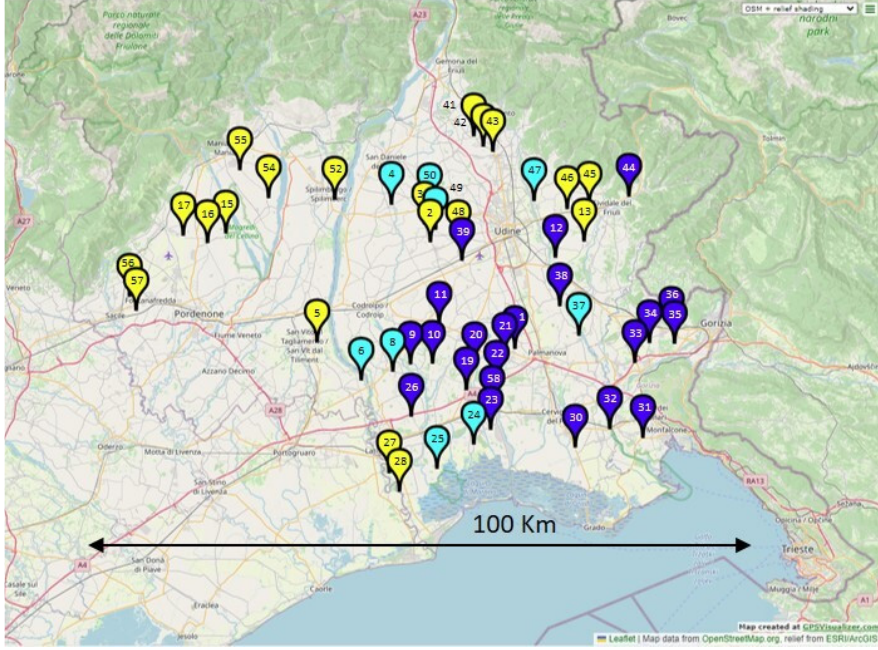
Figure 3. Geographical distribution of the accessions having only the leucine codon (yellow marker), those having only methionine (blue marker) and those having both alleles (cyan). The map was designed with the online tool GPS Visualizer [16].